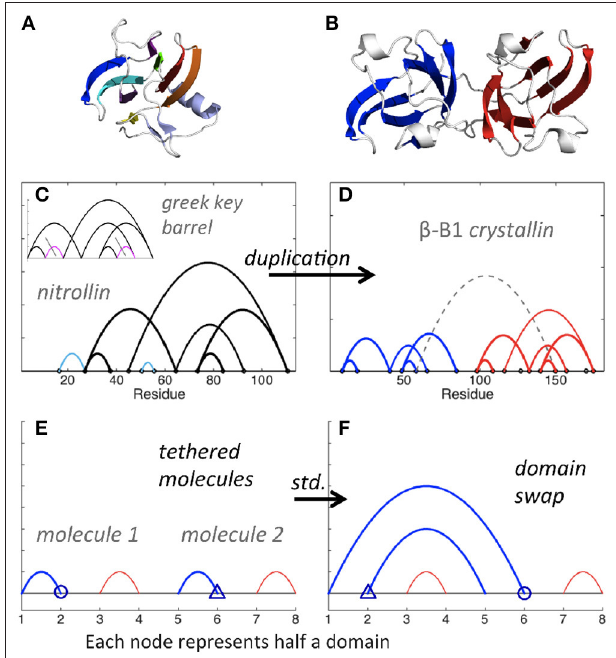
FIGURE 7 | Crystallin and nitrollin diagrams. (A) Nitrollin. (B) Beta-B1 crystallin. (C) Circuit diagram for Nitrollin (3ent), calculated with cutoffs: 3.6, 5. Inset: Greek key barrel with eliminations leading to the nitrollin diagram shown in magenta with gray slashes. (D) Beta-B1 crystallin (1oki), with cutoffs 3.6, 5, and bridge beta sites included. (E) Simplified representation of a crystallin molecule. Here std stands for standard permutation. (F) Simplified representation of hypothesized intramolecular domain swap. Color added for emphasis in all